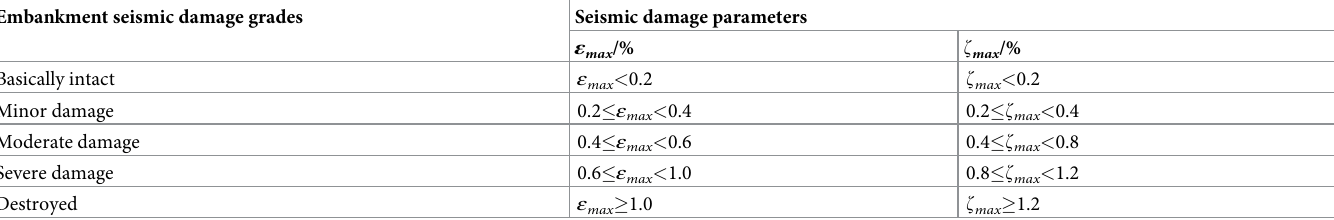
Table 1. Critical values of ε max and z max